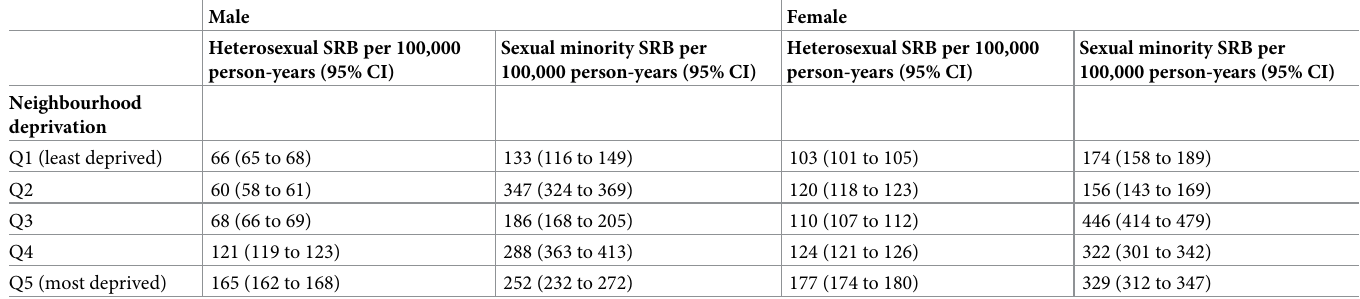
Table 2. Age-adjusted incidence rates of SRB across levels of neighbourhood deprivation (per 100,000 person-years) among Ontarians aged 18+ from 2007–2017, stratified by sex (unweighted n = 169,090; weighted n = 8,778,120 individuals). Male Female Heterosexual SRB per 100,000 Sexual minority SRB per Heterosexual SRB per 100,000 Sexual minority SRB per person-years (95% CI) 100,000 person-years (95% CI) person-years (95% CI) 100,000 person-years (95%